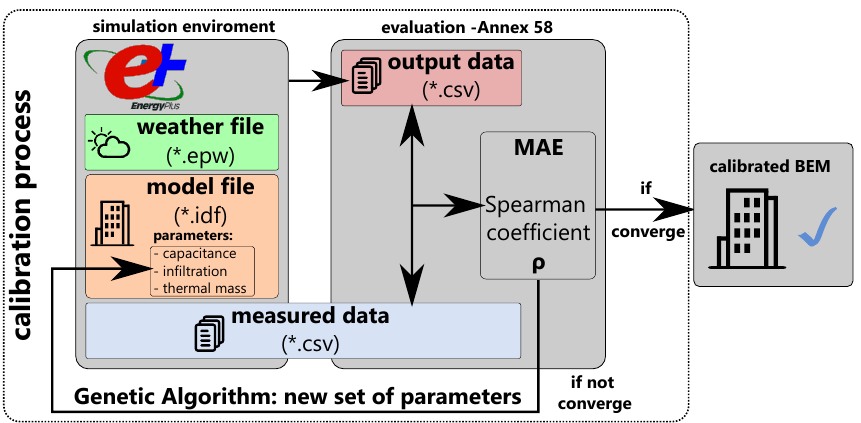
Figure 3. Calibration and evaluation